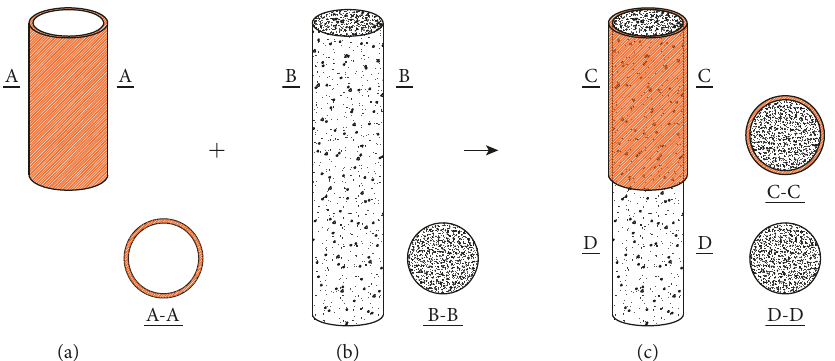
Figure 1: Composition of CCFSTP. (a) Steel casing (SC). (b) Reinforced concrete pile (RCP). (c) Composite concrete-filled steel tube pile